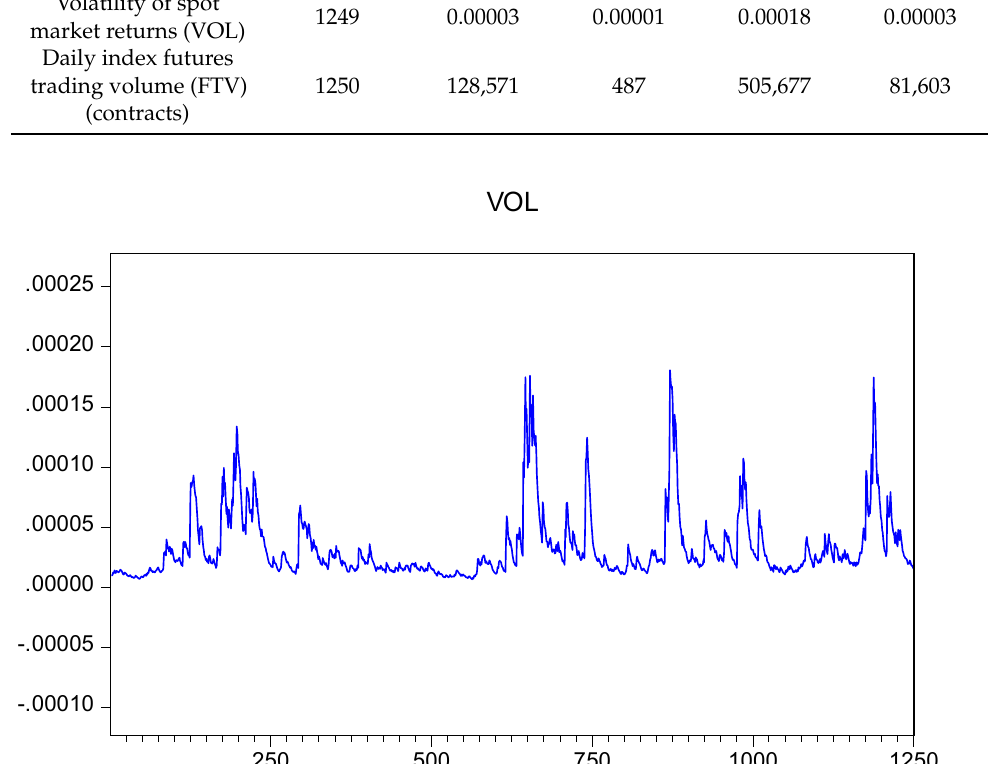
Table 2. Summary statistics of the sample .